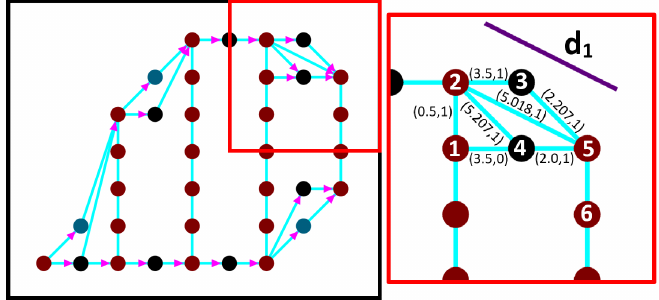
Figure 9. UAV coverage area while passing through edge